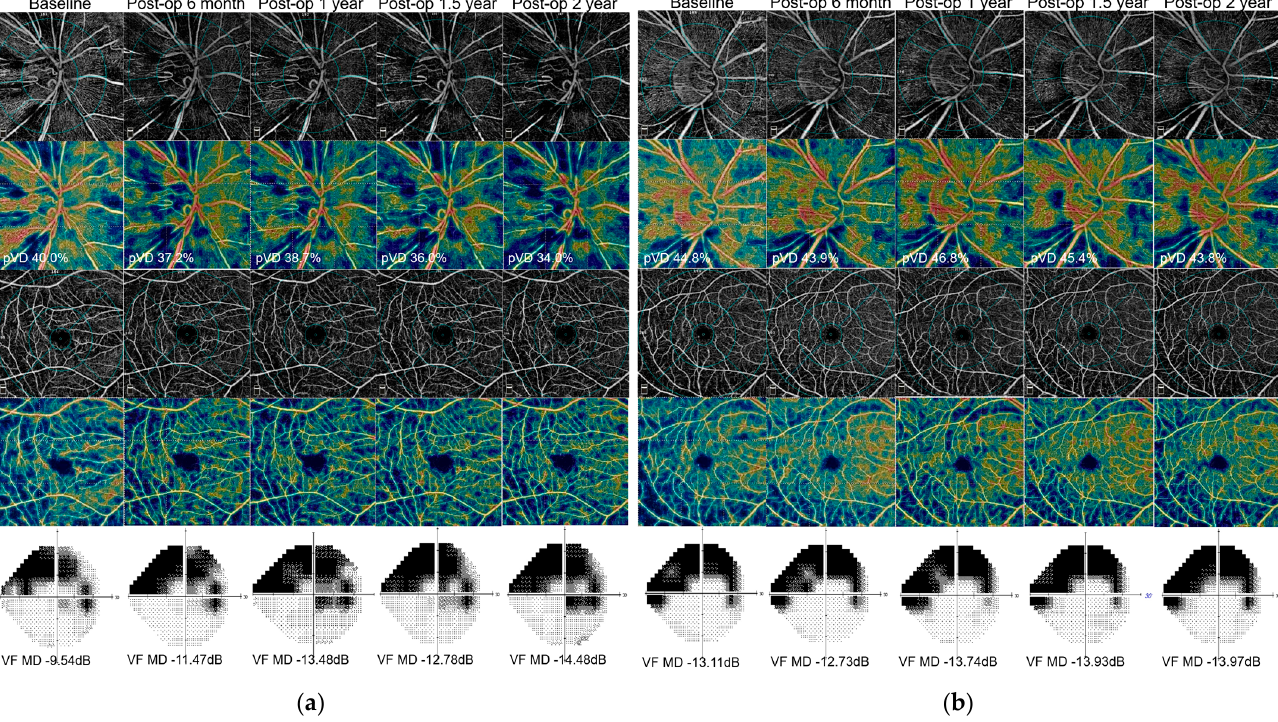
Figure 2. ( a ) A 43-year-old woman with POAG exhibited a gradual loss of peripapillary microcirculation after trabeculec- tomy along with progressive glaucomatous VF progression. ( b ) A 25-year-old woman with POAG showed stable peri- papillary retinal microcirculation and VF after trabeculectomy when assessed for 2 years with a similar level of preopera- tive VF MD and IOP reduction after trabeculectomy. Abbreviations: POAG, primary open angle glaucoma; VF, visual field; IOP, intraocular